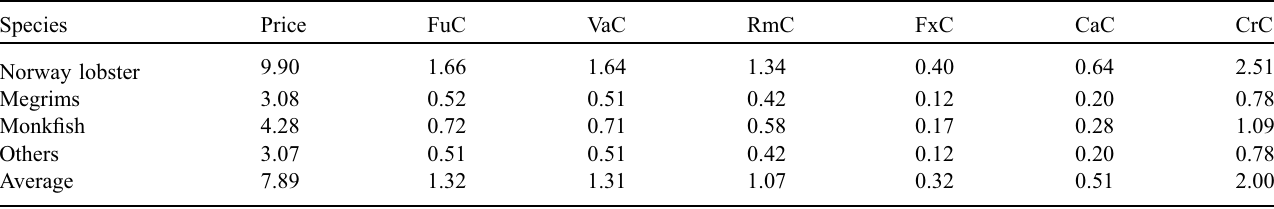
Table A.7. Price and cost structure (fuel costs (FuC), other variable costs (VaC), crew costs (CrC), repair and maintenance costs (RmC), fi xed costs (FxC), capital costs (CaC)) of main species exploited in the NEP fi shery (hake, monk fi sh, megrim) by the polyvalent general þ 18 m fl eet segment in 2019.